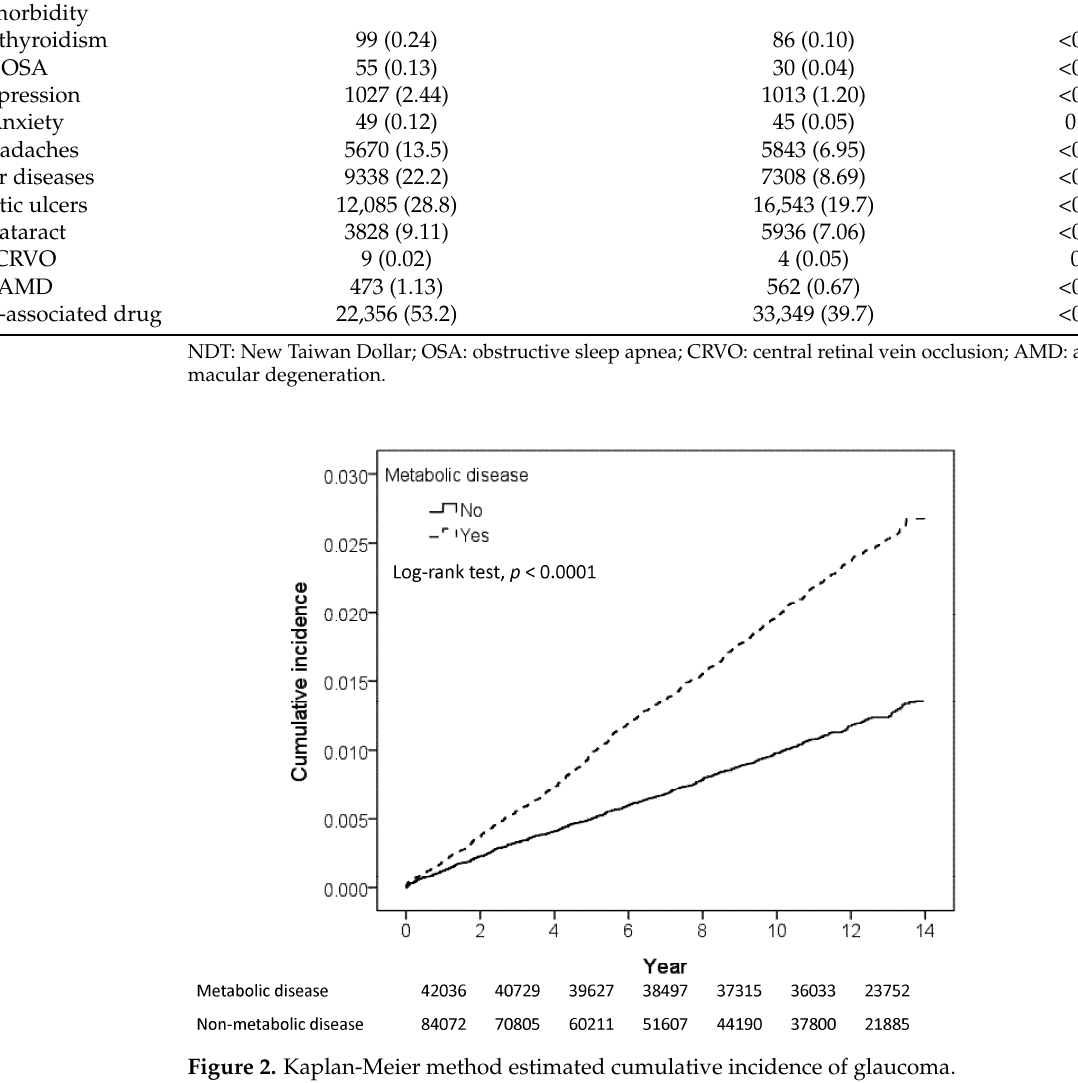
Figure 2. Kaplan-Meier method estimated cumulative incidence of